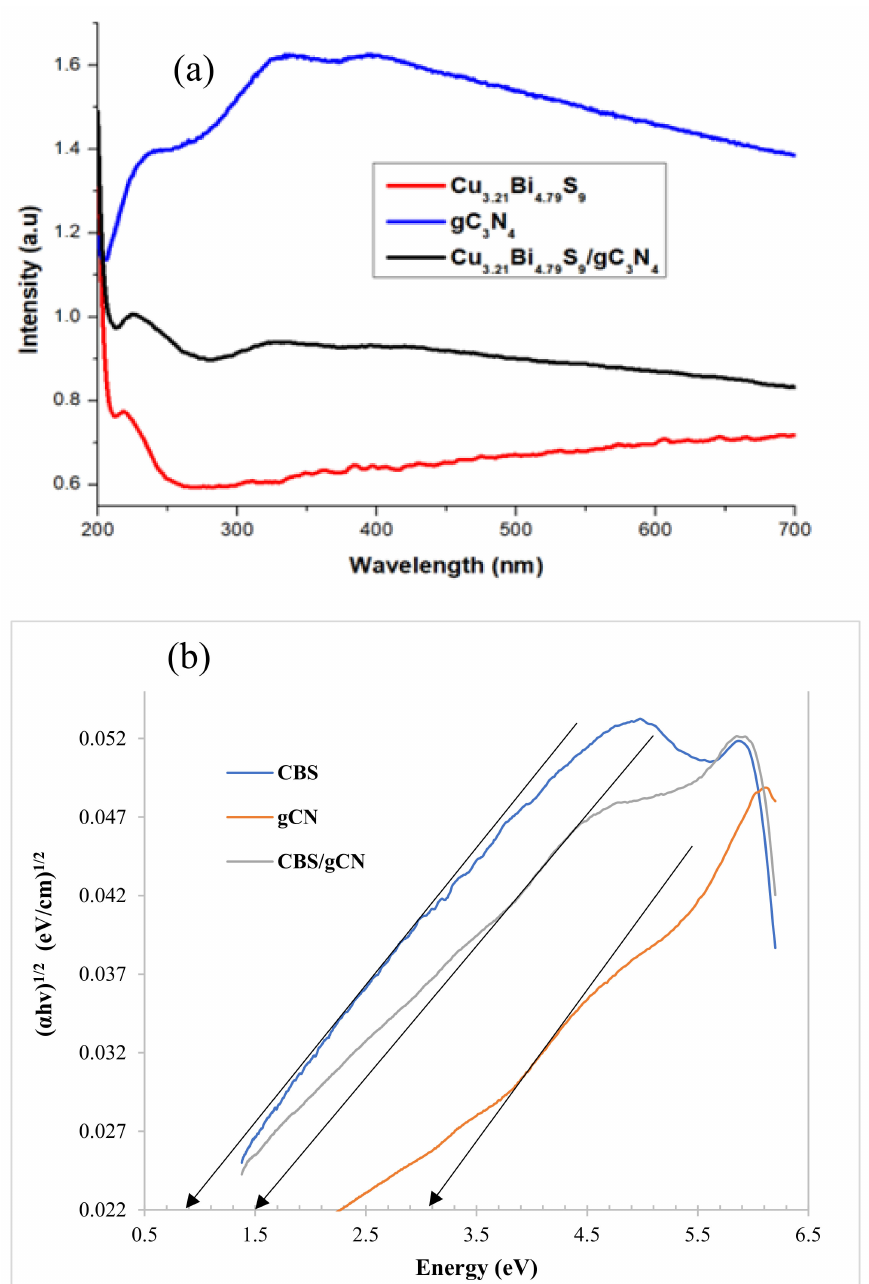
Figure 5. ( a ) Overlaid UV spectra of Cu 3.21 Bi 4.79 S 9 , gC 3 N 4 , and Cu 3.21 Bi 4.79 S 9 /gC 3 N 4 ; ( b ) Tauc plot of Cu 3.21 Bi 4.79 S 9 (CBS), gC 3 N 4 (gCN), and Cu 3.21 Bi 4.79 S 9 /gC 3 N 4